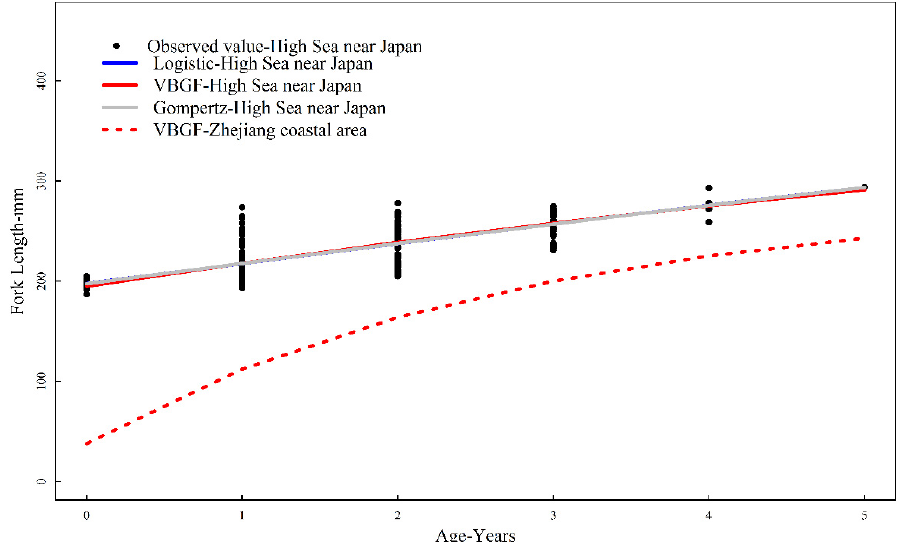
Figure 8. The length-at-age curves for Chub mackerel specimens collected from coastal waters off the northwest Pacific Ocean .